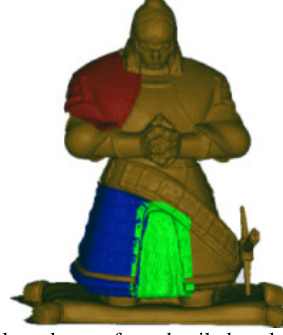
Figure 6. Difference model: TLS-Nikon Arc3d